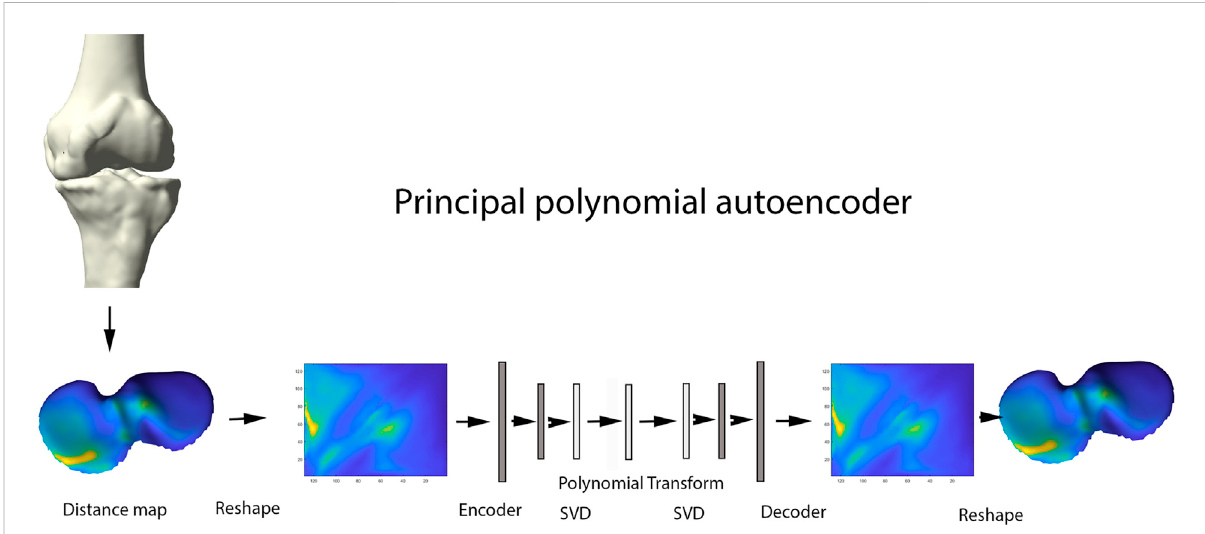
FIGURE 5 Representation oftheprincipalpolynomialautoencoder(PPAE).Anatomicallystandardizeddistancemapsareencodedtopixel images,serving as input for theautoencoder. Singular value decomposition and consequentpolynomial regressionreplace thelast layer of theencoder and the fi rst layer of the